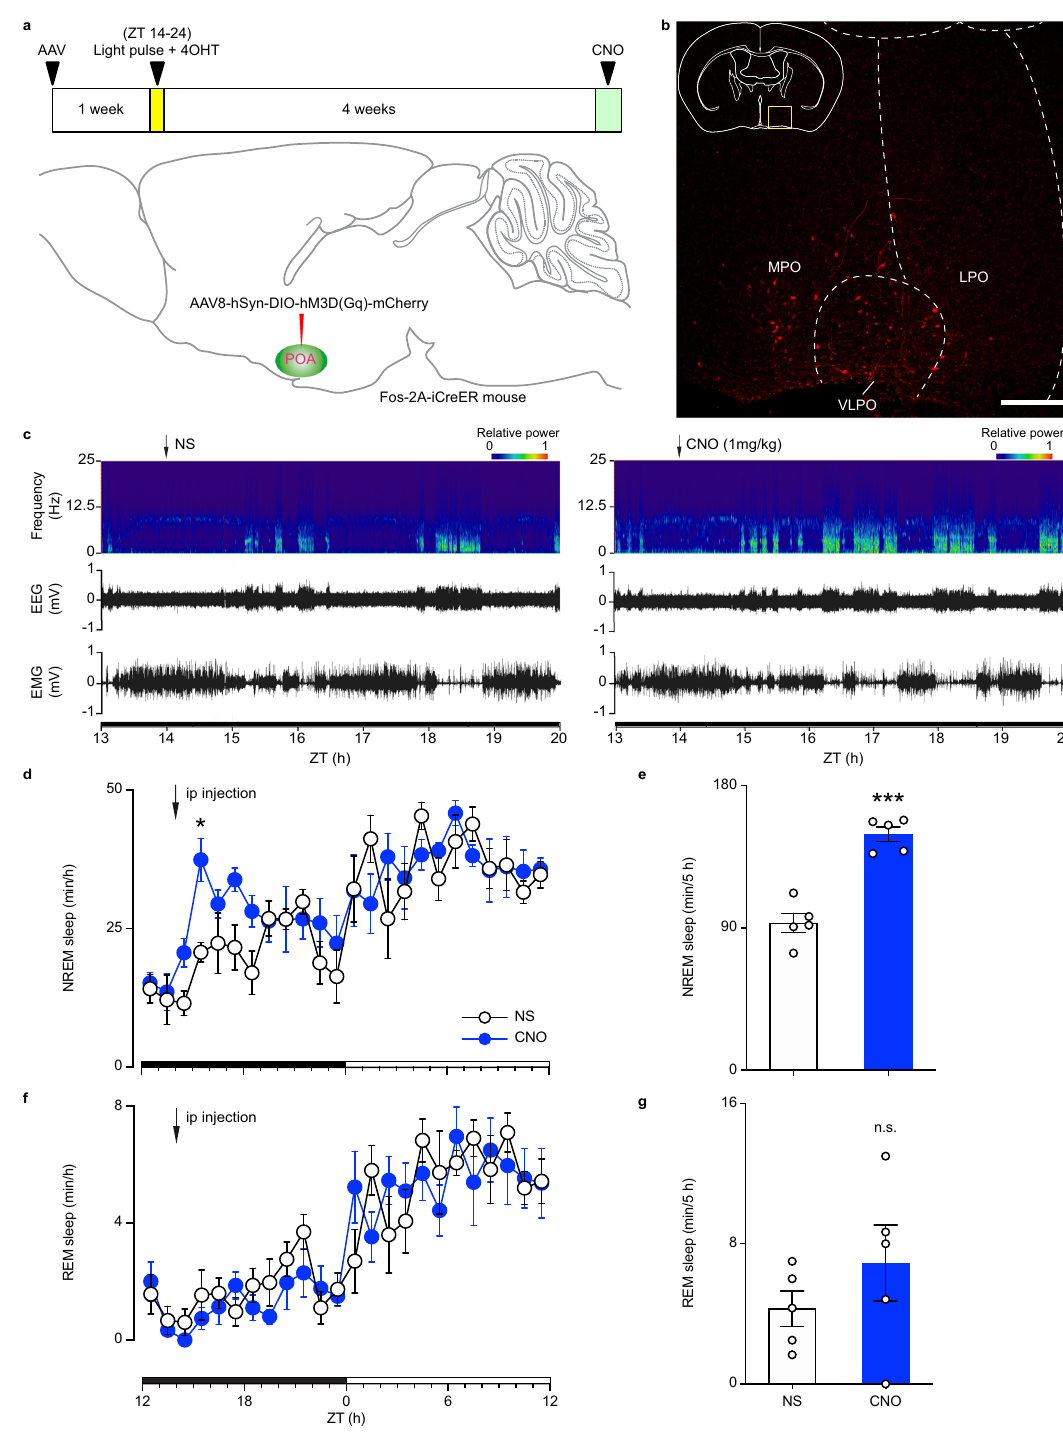
Fig. 2 Activation of POA light-responsive neurons increased NREM sleep but not REM sleep. a Schematic showing virus injection, light exposure, 4-Hydroxytamoxifen (4-OHT) injection, and CNO injection. b Immunostaining of mCherry in the POA ( n = 5 animals; scale bar, 200 μ m). c Typical examples of relative electroencephalogram (EEG) power (normalized by the highest power in each frequency band) and EEG/electromyogram (EMG) traces over 6 h following normal saline (NS) injection (left) or clozapine-N-oxide (CNO) injection (right) at zeitgeber time (ZT) 14. d Time course changes in NREM sleep after NS or CNO injection ( n = 5 animals; two-way ANOVA (ZT 14 to ZT 19), F 1, 8 = 53.17, P = 0.000085, Bonferroni post hoc test, * P < 0.05). Each cycle represents the hourly mean ±SEM of sleep. The black and white bars on the x axes indicate light-off and light-on periods, respectively. e Total time sleep in NREM sleep for 5 h after NS or CNO injection ( n = 5 animals; two-tailed Student ’ s t test, t 4 = 11.94, P = 0.0003, *** P < 0.001). f Time course changes in REM sleep after NS or CNO injection ( n = 5 animals; two-way ANOVA, F 1, 8 = 0.5324, P = 0.4864, Bonferroni post hoc test). g Total time sleep in REM sleep for 5 h after NS or CNO injection ( n = 5 animals; two-tailed Student ’ s t test, t 4 = 0.8894, P = 0.4241). All error bars denote SEM. MPO, medial preoptic area; LPO, lateral preoptic area; VLPO, ventrolateral preoptic nucleus; n.s., non-signi fi cant; NREM, non-rapid eye